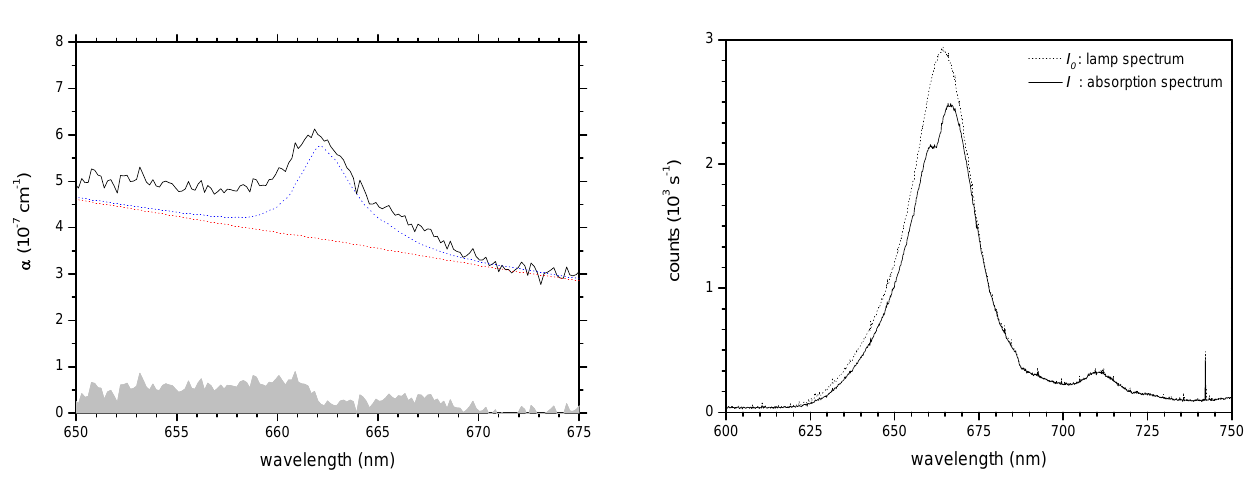
Figure 5. Recorded CE-DOAS spectra during the NO 3 / N 2 O 5 intercomparison campaign 3 Fig. 5. Recorded CE-DOAS spectra during the NO 3 /N 2 O 5 inter- (transmitted intensity of the resonator). (a) I 0 (lamp) spectra were recorded overnight by 4 comparison campaign (transmitted intensity of the resonator). (a) averaging 572 scaled spectra (dotted line). (b) During experiments five spectra were averaged 5 I 0 (lamp) spectra were recorded overnight by averaging 572 scaled (solid line). This absorption spectrum ( I ) shows the attenuation corresponding to 631 pptv 6 spectra (dotted line). (b) During experiments five spectra were av- NO 3 . 7 eraged (solid line). This absorption spectrum ( I) shows the attenu- ation corresponding to 631pptv NO 3